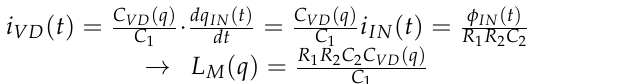
Figure 19. Universal circuit proposed by Yu et al. [62] for the emulation of floating memcapacitors ( a ), and floating meminductor ( b ).